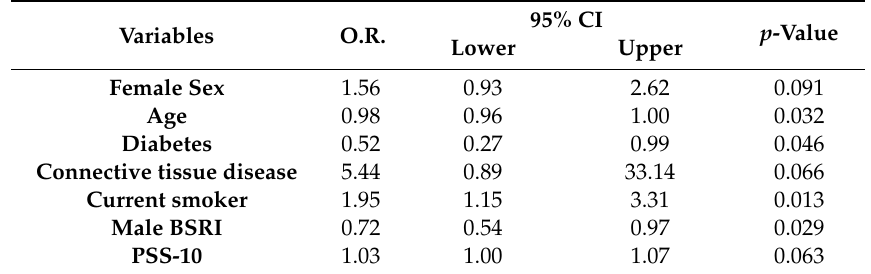
Table 4. Factors associated with low adherence to the Mediterranean diet, evaluated by univariate analysis.